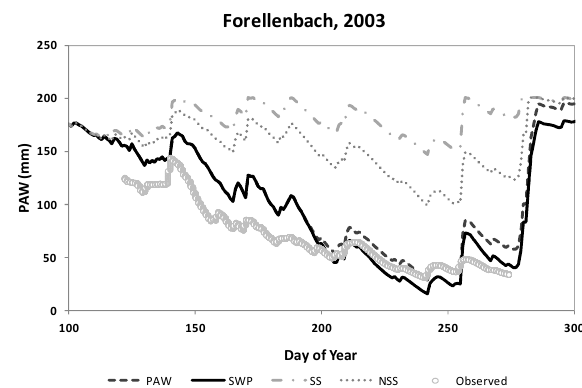
Fig. 5. (a) Precipitation and modelled f SWP for a beech stand at Kranzberger Forst in 2003 using the SWP model (see methods sec- tion for details); (b) Observed and modelled leaf-level g sto for the same year, stand and soil water calculation method; (c) Observed and modelled soil water content (SWC) using all four methods that relate soil water to g sto (see methods section for details).